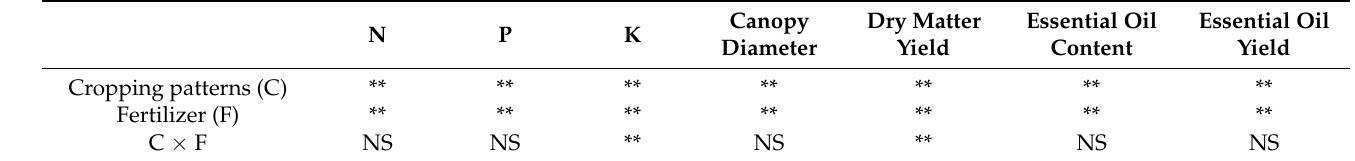
Table 2. The analysis variance of marjoram nutrient content, productivity, essential oil content, and